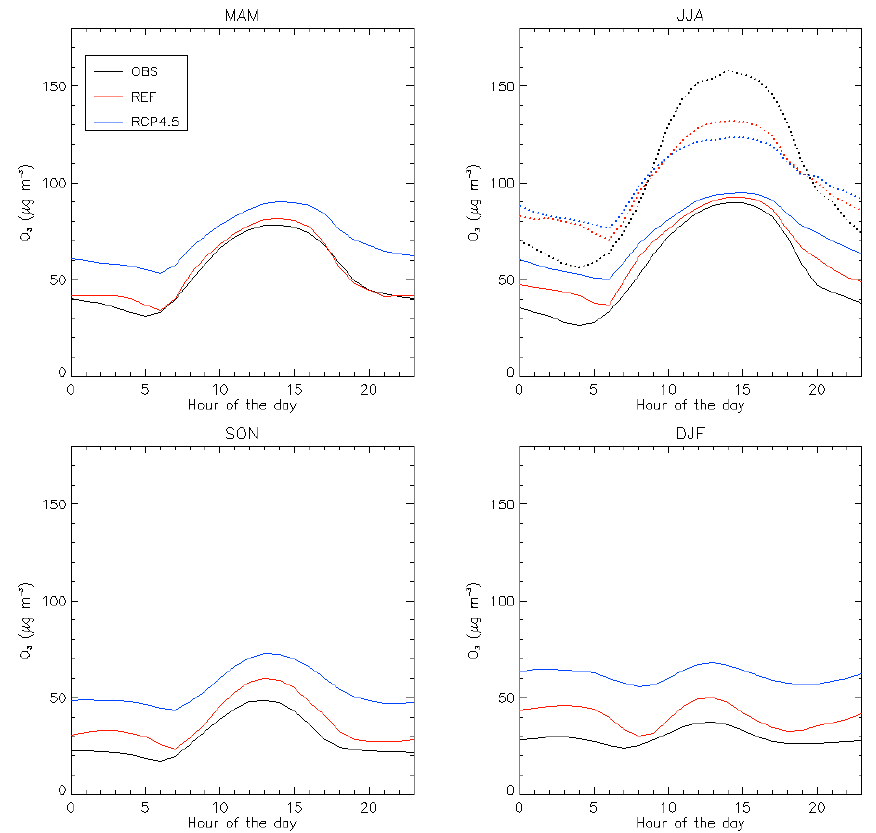
Figure 5. Mean daily cycle of O 3 concentrations at station Lanaken per season. In summer, also the 95th percentile is plotted (dotted